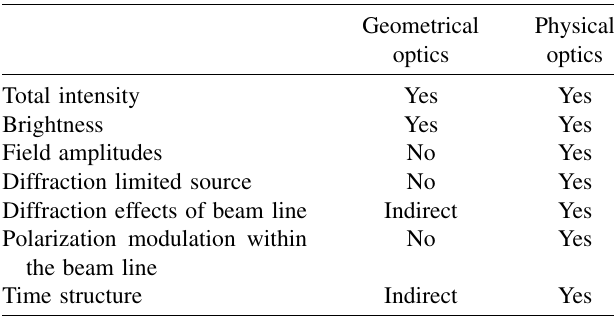
TABLE I. Comparison of geometrical and physical optics